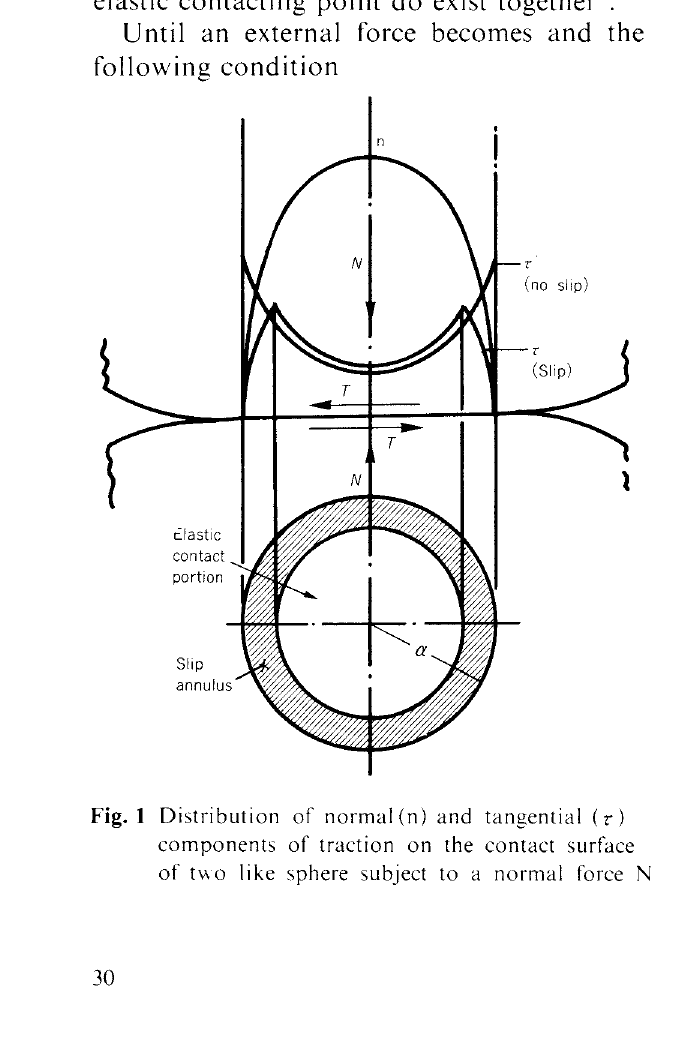
Fig. I Distribution of normal (n) and tangential ( r) components of traction on the contact surface of t\\ o I ike sphere subject to a normal force